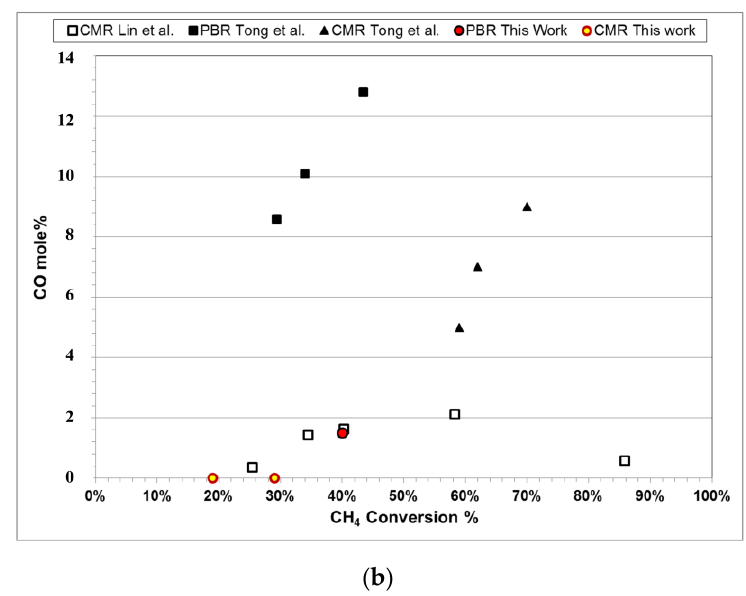
Figure 12. Comparison of the results presented in this work against those presented in the literature for ( a ) methane conversion and ( b ) CO yield at 450–500 °C and 2–5 bar [10,42–44].